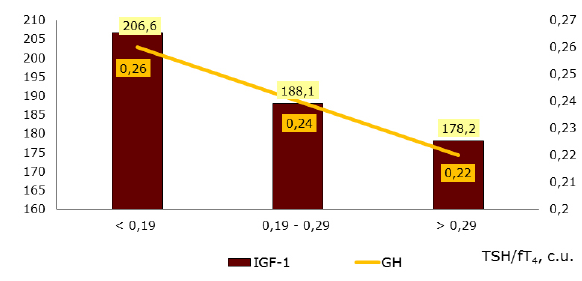
Figure 5. Indicators of GH and IGF-1 in pa- tients with type 1 diabetes depending on the level of TSH/ fT 4,